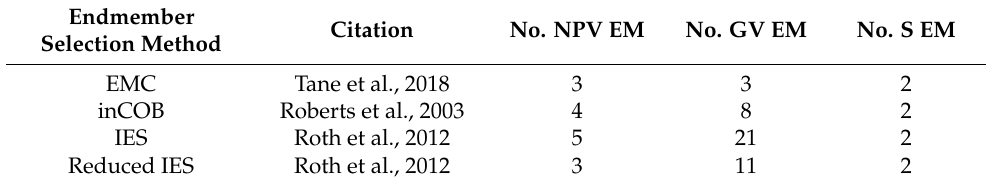
Table 2. Results of four endmember (EM) selection methods on spectral library